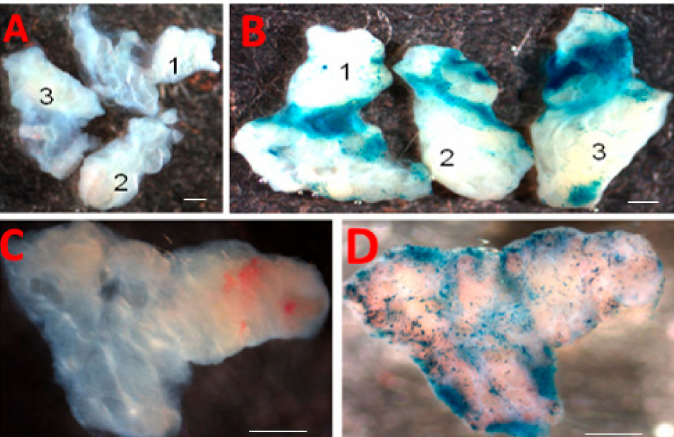
Figure 3. Test for feasibility of functional studies with the 3D endometrial slice culture model. Endometrial slices from 3D model were transduced with adenovirus expressing LacZ (Ad-LacZ) and subsequently stained by the β -galactosidase staining procedure (LacZ staining). ( A ) Tissue slices photographed before LacZ staining; ( B ) the same tissue slices photographed after LacZ staining. ( C ) Magnified view of a tissue slice before LacZ staining; ( D ) Magnified view of the same tissue slice photographed after LacZ staining. Scale bar = 1